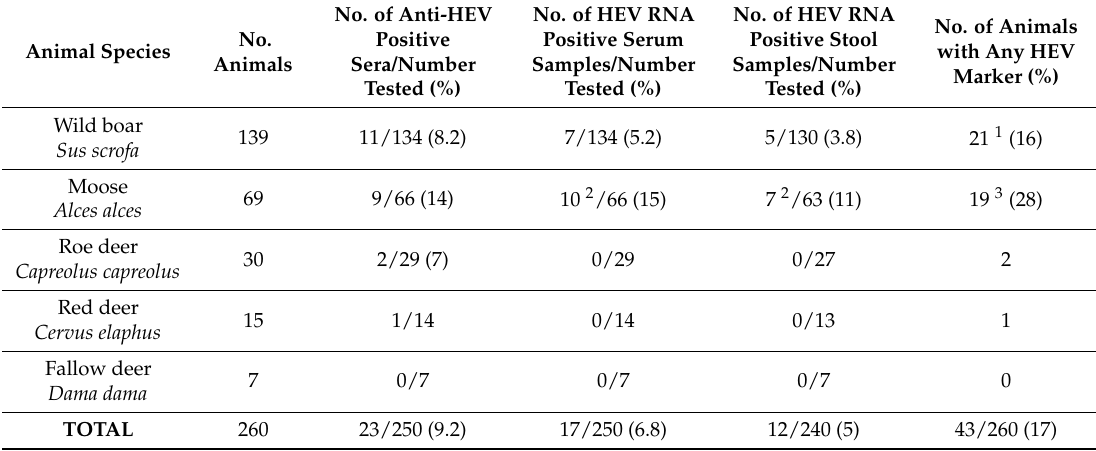
Table 2. Hepatitis E markers identified in serum and fecal samples from the different species of animals.